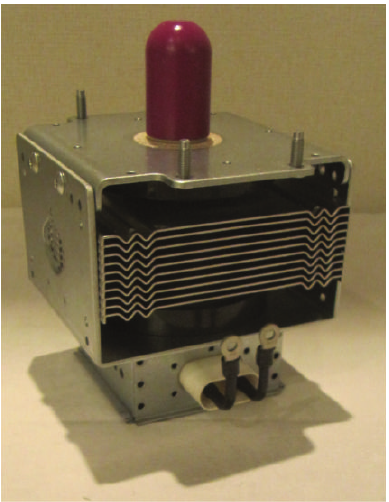
Figure 1: Typical water jacket—air cooled 2.45 GHz magnetron (1.5 or 2.0 kW,